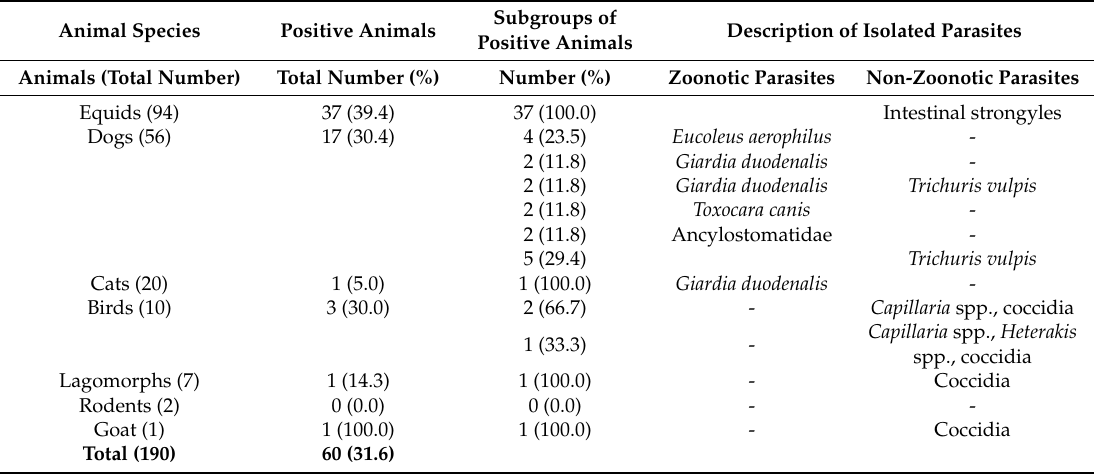
Table 1. Copromicroscopic results: number of investigated and positive (%) animal species and description of the isolated